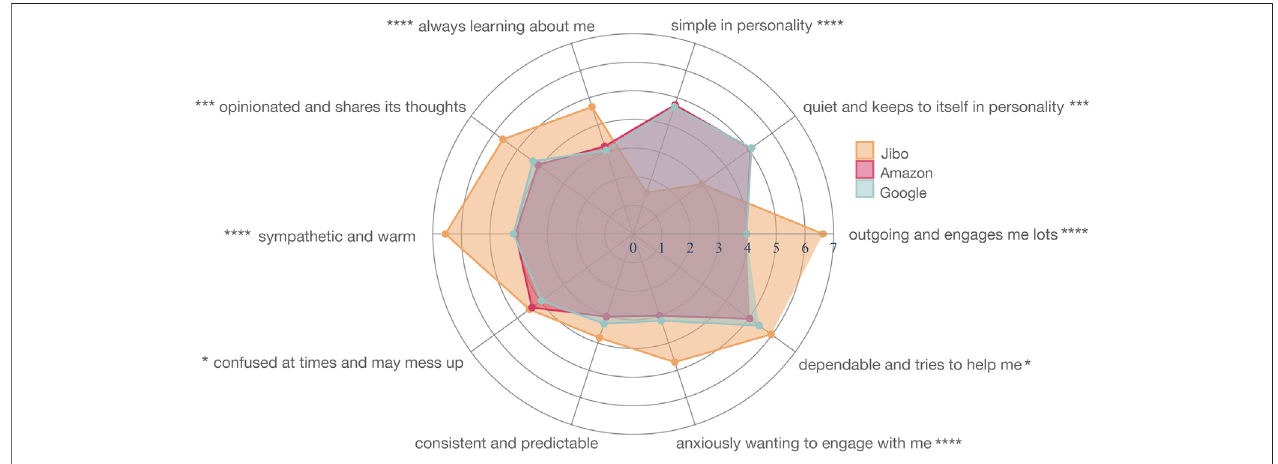
FIGURE 8 | Personality mapping for Jibo (orange), Amazon (red), and Google (blue) in Study 2